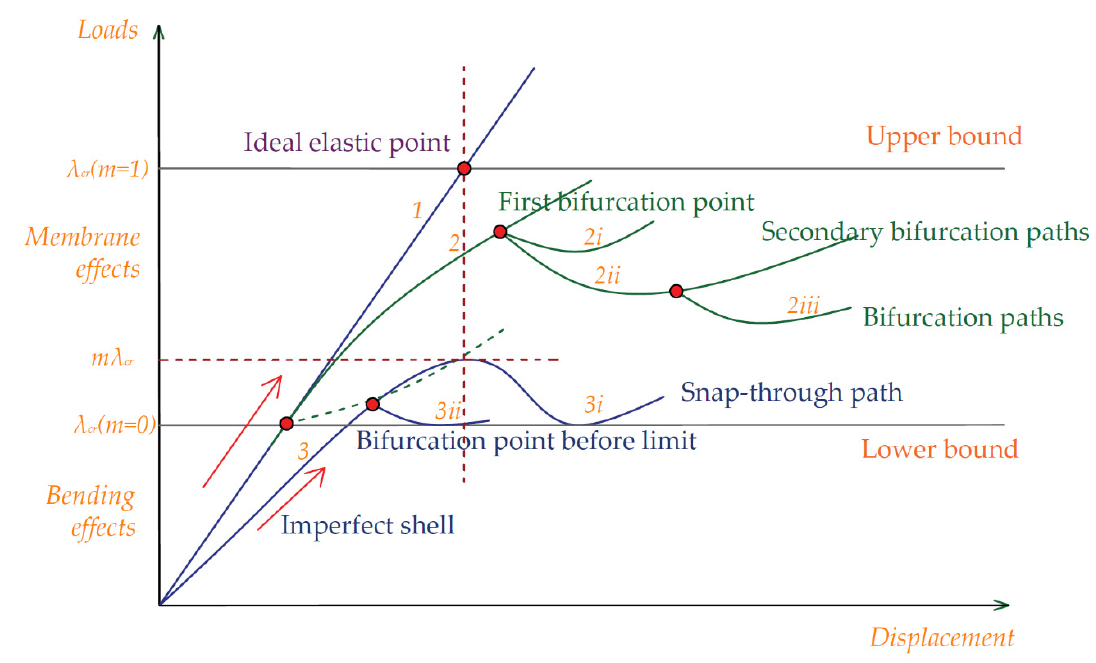
Figure 1. Types of buckling behaviour.